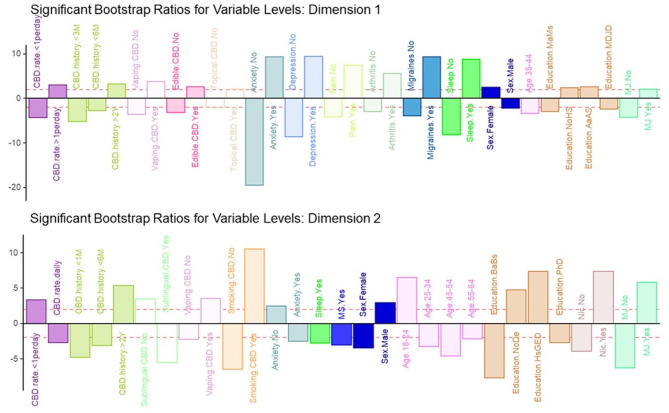
Significant bootstrap ratios for dimensions 1 & 2. Illustration of the significant bootstrap ratios for the variables for dimensions 1 and 2. Bars that are filled-in represent variables with a bootstrap ratio >2. Variables in the same side of the y-axis are positively associated with each other.